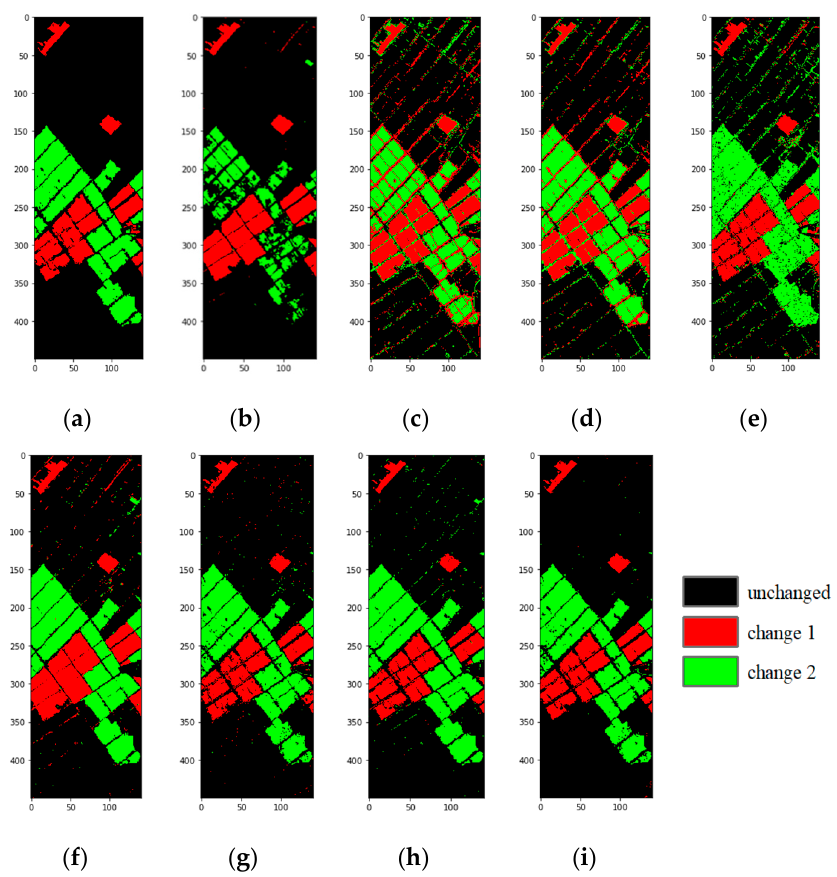
Figure 8. Spectral curves at different noise levels: ( a ) without noise; ( b ) with Gaussian white noise (variance = 0.001); ( c ) with Gaussian white noise (variance = 0.003); ( d ) with Gaussian white noise (variance = 0.005). Experimental results of the simulated dataset under different levels of noise : ( e ) the OA of each method for the simulation dataset under different levels of noise; ( f ) the KAPPA of each method for the simulation dataset under different levels of noise.